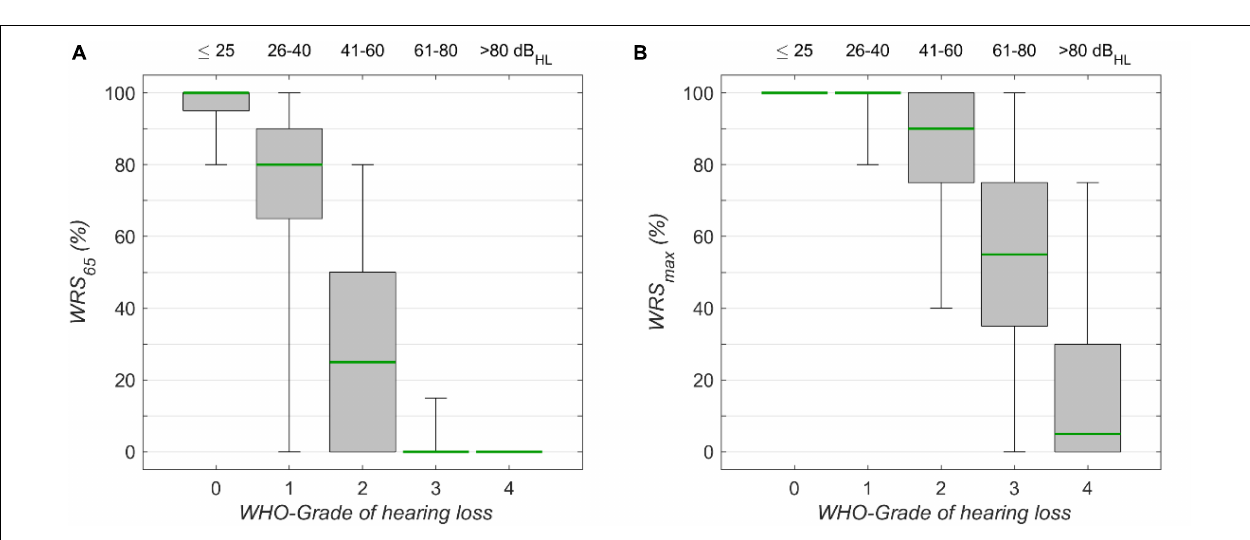
FIGURE 3 | The monosyllabic score (A) at 65 dB SPL presentation level (WRS 65 ) and (B) the maximum word recognition score (WRS max ), for different WHO grades of hearing loss. Corresponding 4FPTA ranges are shown on the upper x-axis. The boxplots show medians (green) with 1st and 3rd quartiles. The whiskers denote the 2.5 and 97.5